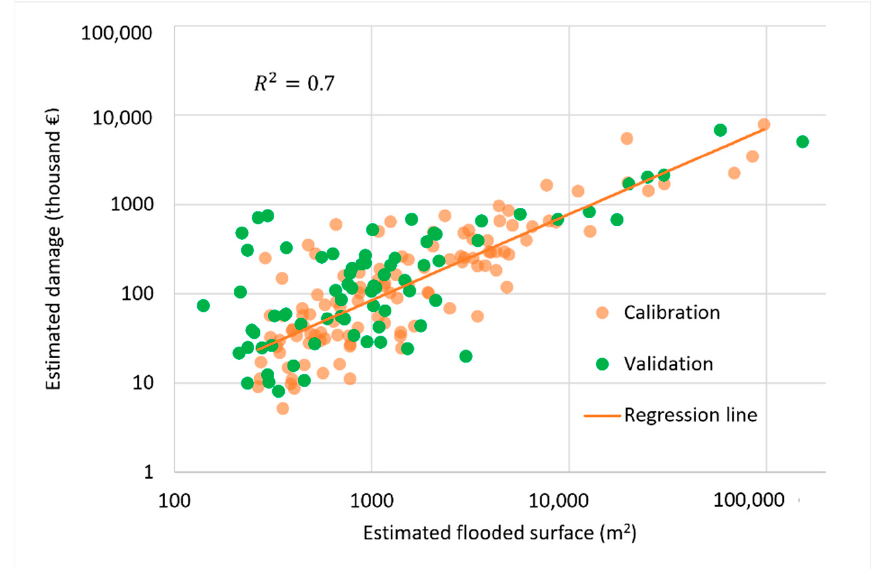
Figure 7. Calibration results. Each point corresponds to data aggregated at the scale of a single municipality. The regression line has been derived from the calibration dataset: the validation dataset fits well the curve.